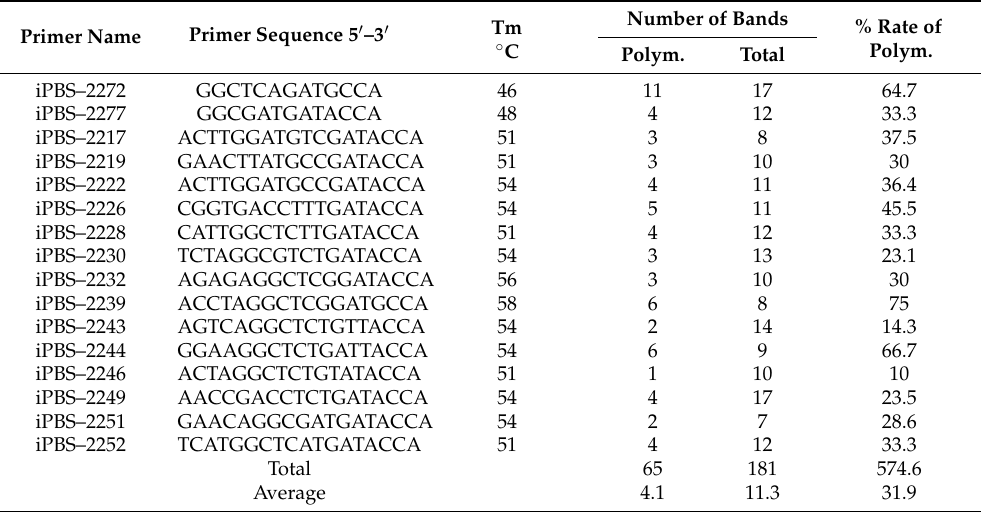
Table 4. Primer name, primer sequence, numbers of bands, and percentage of polymorphism detected by iPBS.